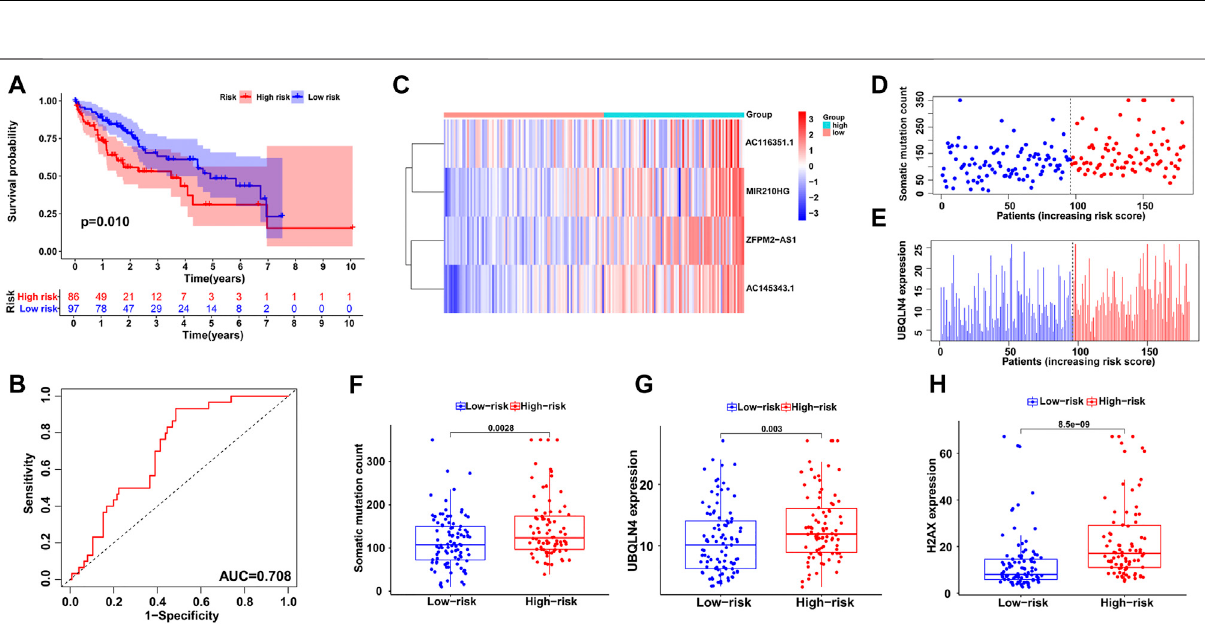
Frontiers in Genetics |